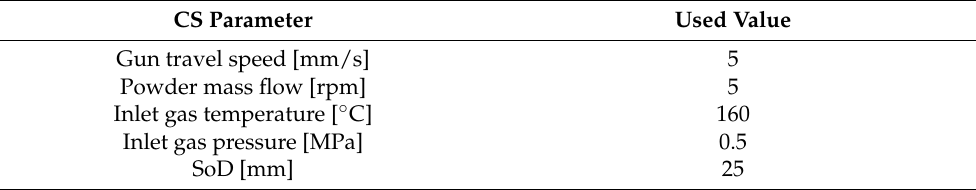
Table 1. Suitable CS process parameters used in this